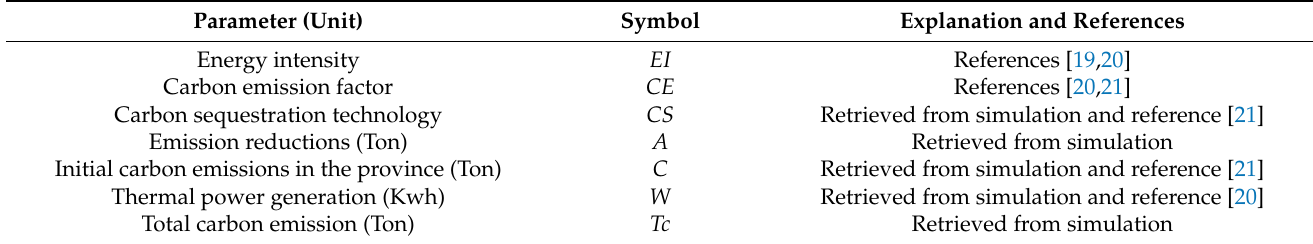
Table 1. Variable